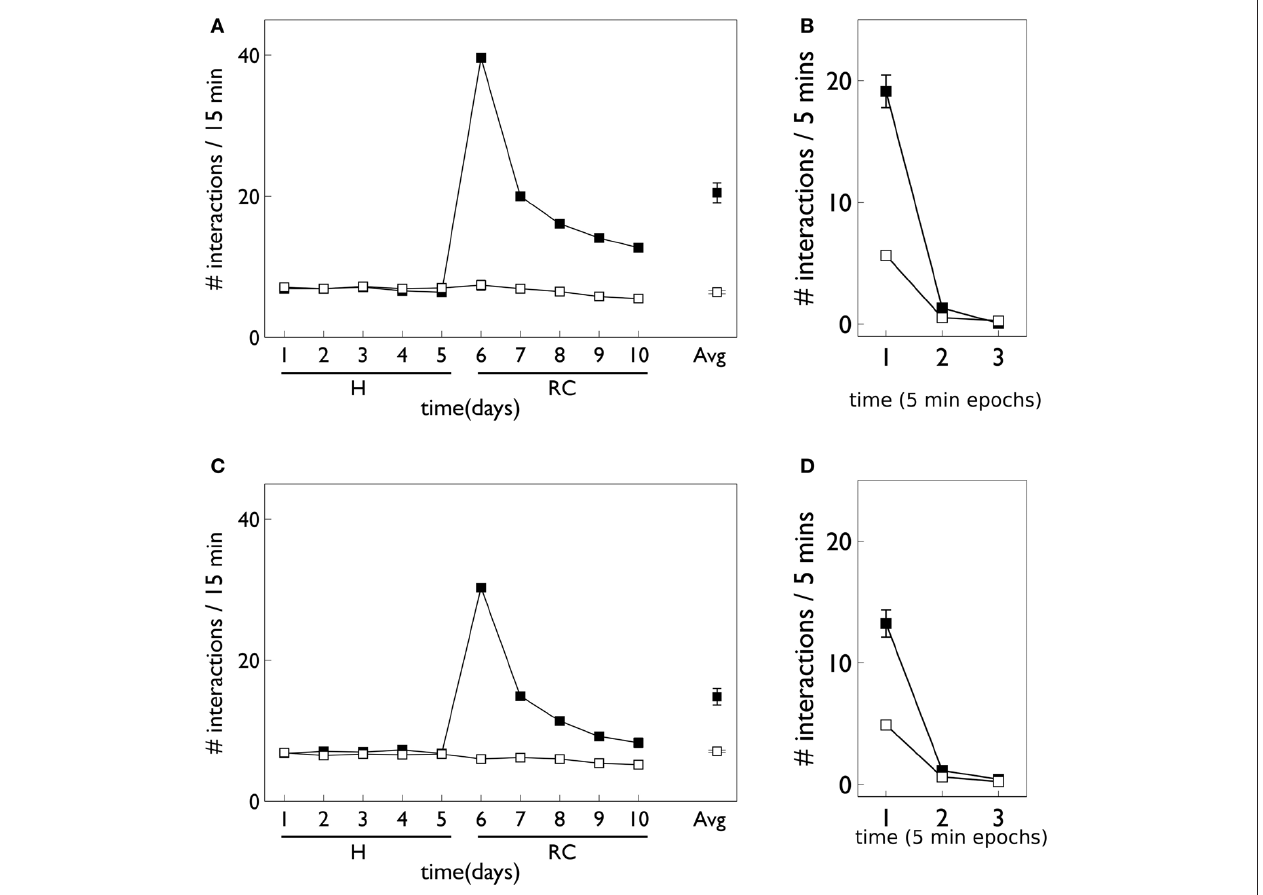
FIGURE 12 | Behavior of an agent with novelty salience and feature prediction performing the block-bumping experiment with fixed-ratio training. All panelshave thesame significanceas theircounterpartsforvariableintervaltrainingin Figure 9 .Thus, (A,B) are forpDAmodels,whereas (C,D) are